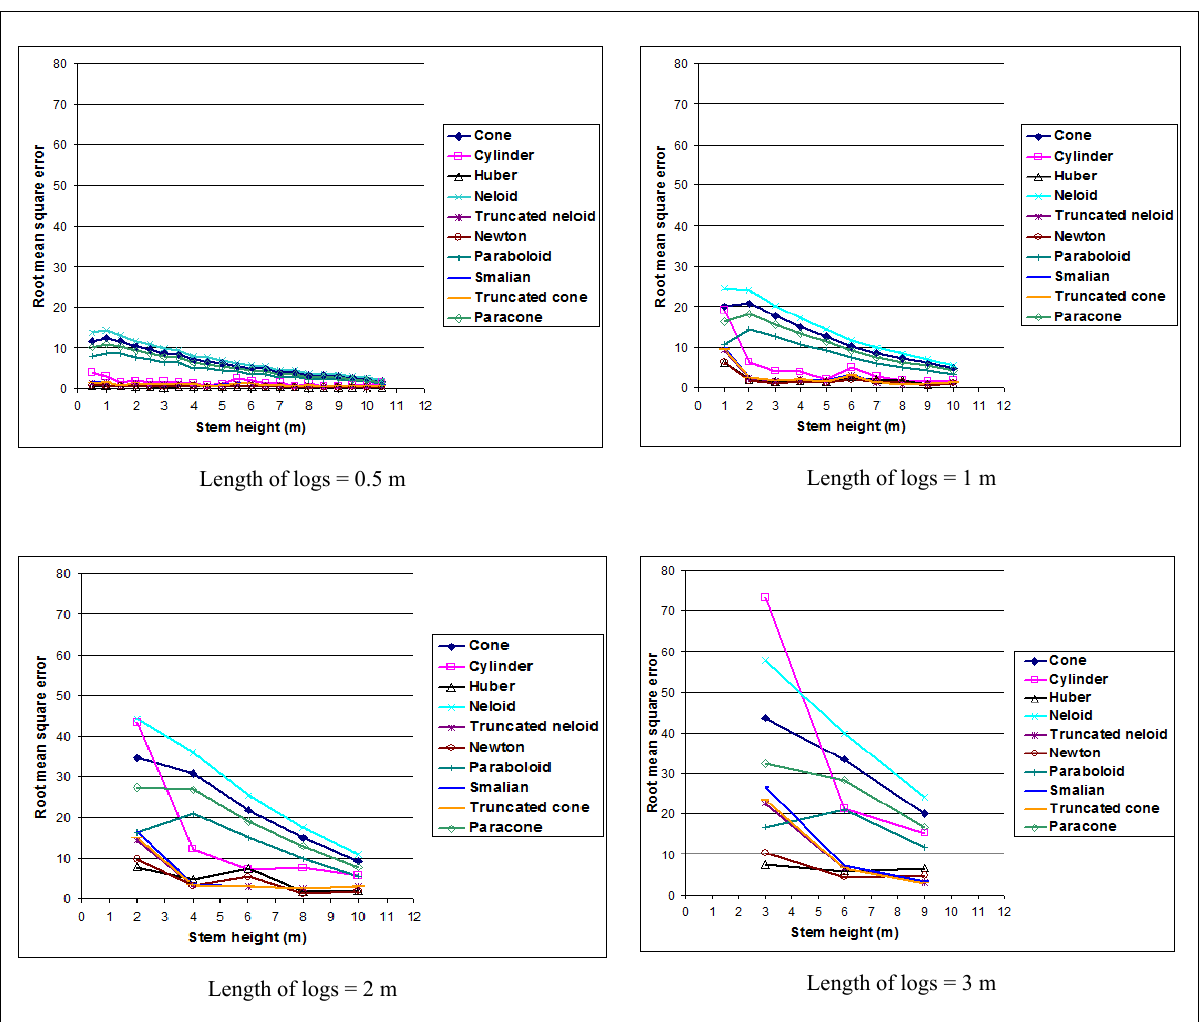
Figure 2. Trend of the mean squared error along the